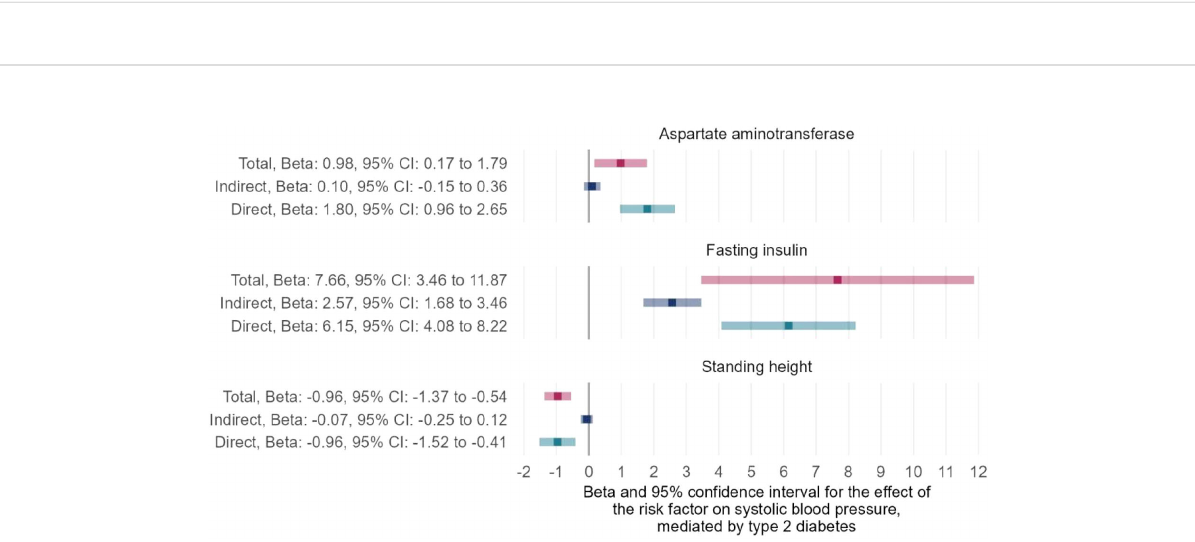
FIGURE 3 Two-step MR for mediation analyses showing the total, indirect (mediated by T2DM), and direct (independent of T2DM) effects of the traits on SBP. MR, Mendelian Randomization; T2DM, type 2 diabetes mellitus; SBP, systolic blood pressure.